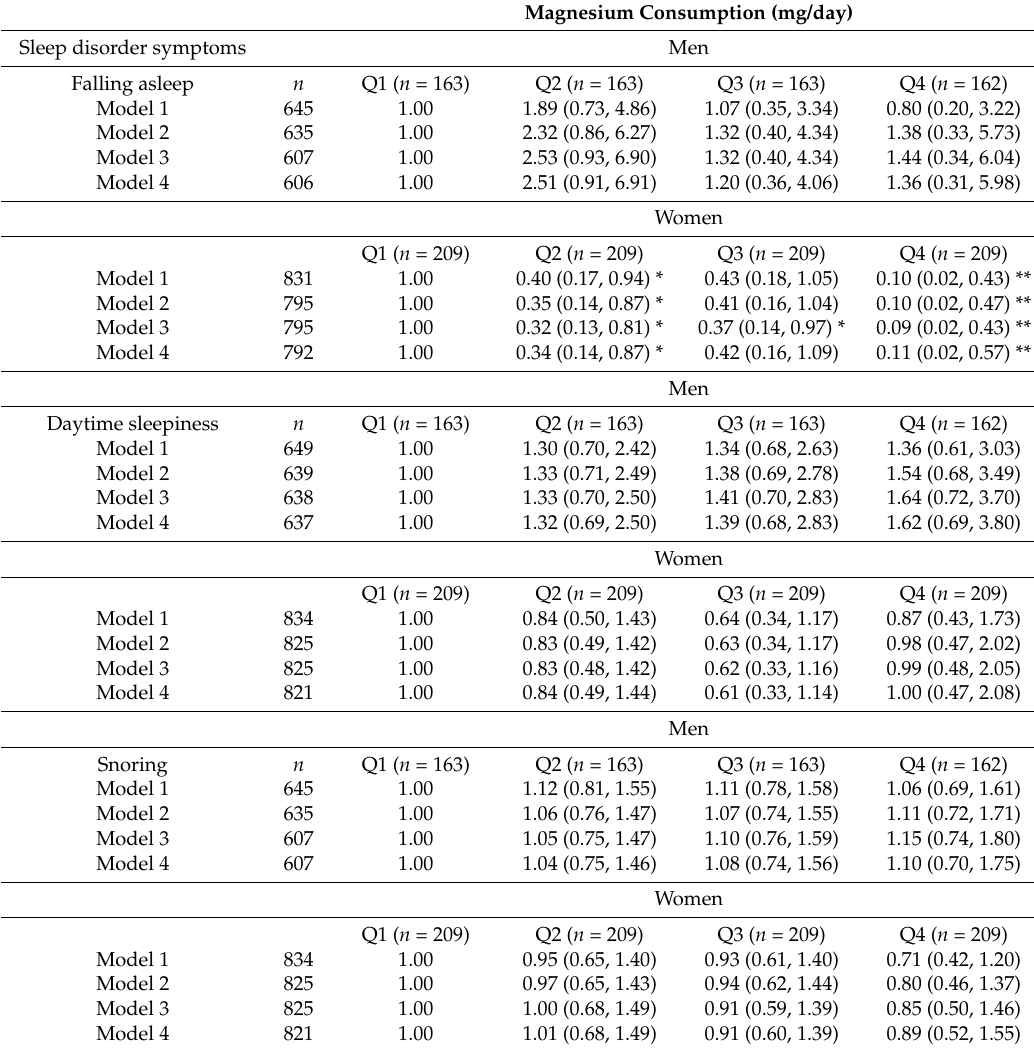
Table 3. The odds ratios (OR (95% CI)) of self-reported sleep disorder symptoms at follow-up (2007) according to magnesium consumption (mg) quartiles at baseline (2002) ( n = 1487) 1